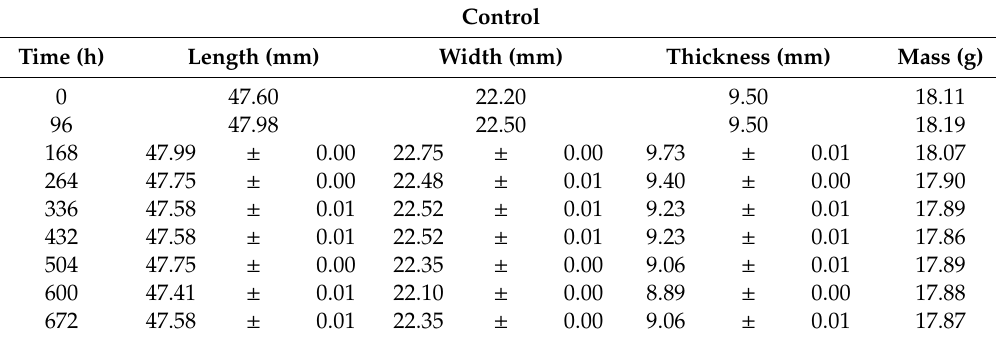
Table 2. Control sample dimension and mass change